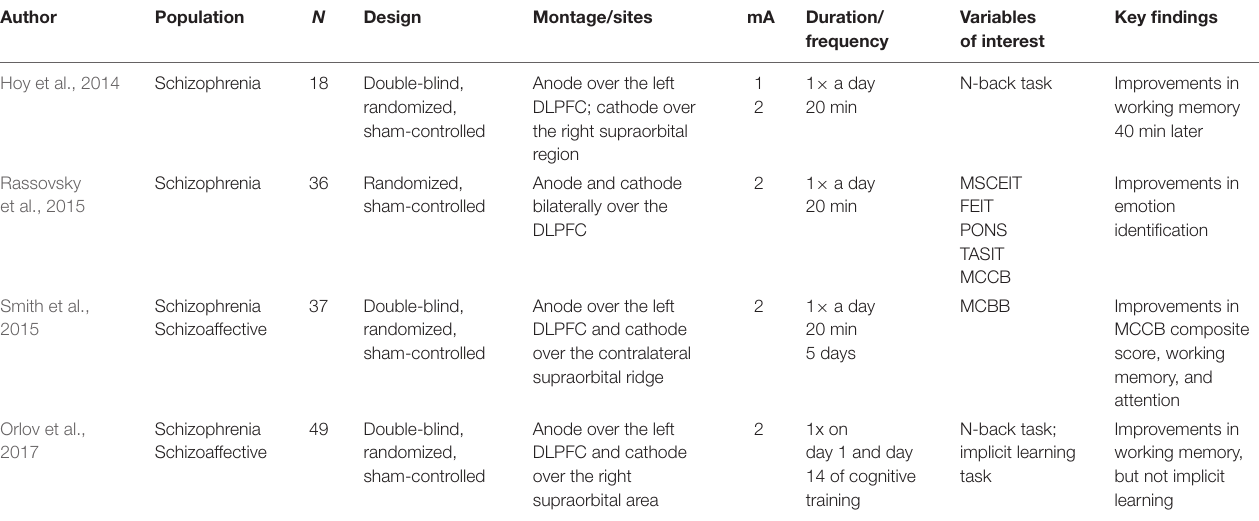
TABLE 2 | Summary of tDCS and cognition studies